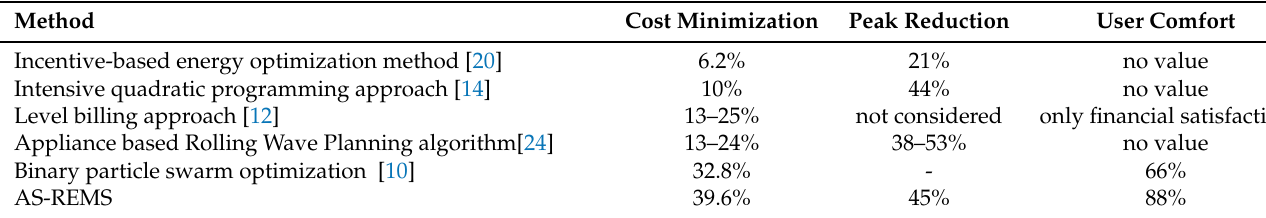
Table 14. Comparision of AS-REMS with the recent REM studies in the